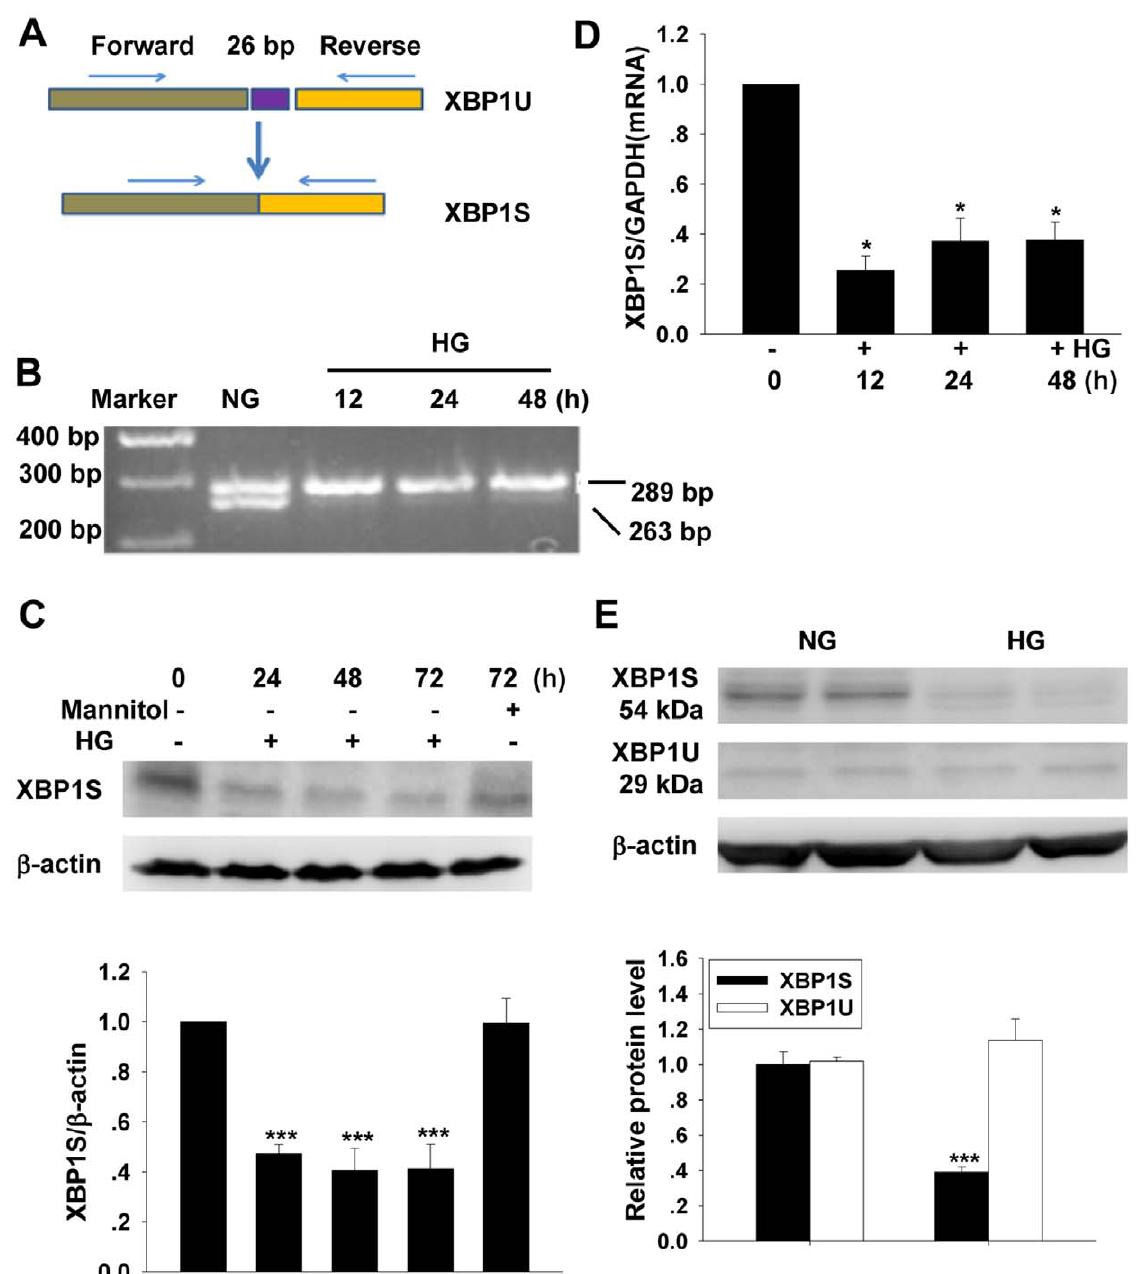
Figure 1. Effect of high glucose on the expression of XBP1S. A: diagram shows the formation of XBP1S from XBP1U mRNA, a 26 bp fragment (from 484 to 509) was deleted during splicing. B: electrophoresis of RT-PCR products indicates MCs expressed both XBP1U and XBP1S. C and D: Western blot and real time PCR result show the expression of XBP1S before and after high glucose treatment (mean 6 SEM, n=5).E: Western blot result shows the expression of XBP1U before and after high glucose treatment for 48 h (mean 6 SEM, n=6) * p , 0.05 compared to NG; *** p , 0.001 compared to NG.